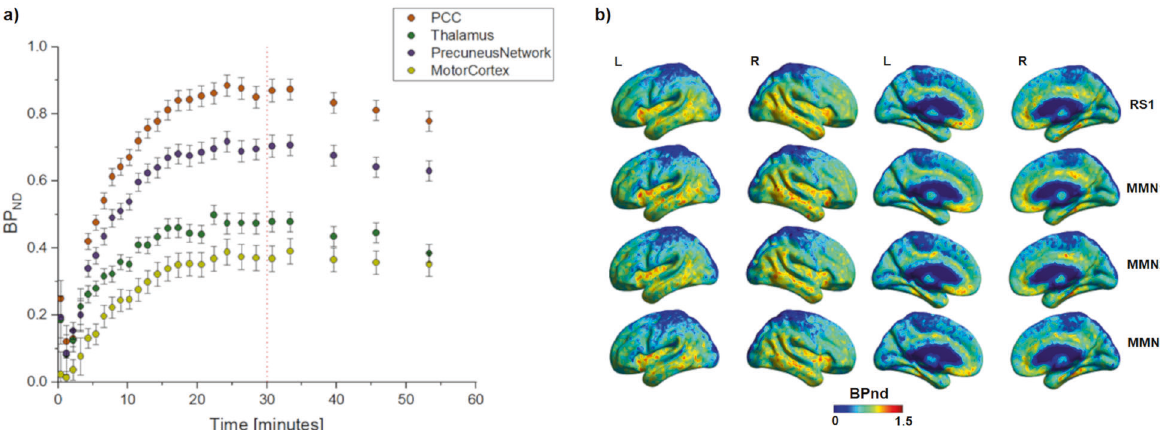
Fig. 4 Task effect results shown by the regional and voxel-wise cerebral uptake of [C]ABP688 expressed as distribution volume referenced to cerebellum grey matter, BP. a BP ND curves for the anatomical and functional brain regions analyzed. Signi fi cant effects can be seen in the healthy group. The red line marks the start point of tracer equilibrium phase. After 30 min, the fi rst two time points represent RS 1 and the remaining three time points represent the MMN task moments (MMN 1 , MMN 2 , and MMN 3 ). b BP ND parametric images for the group average per acquisition